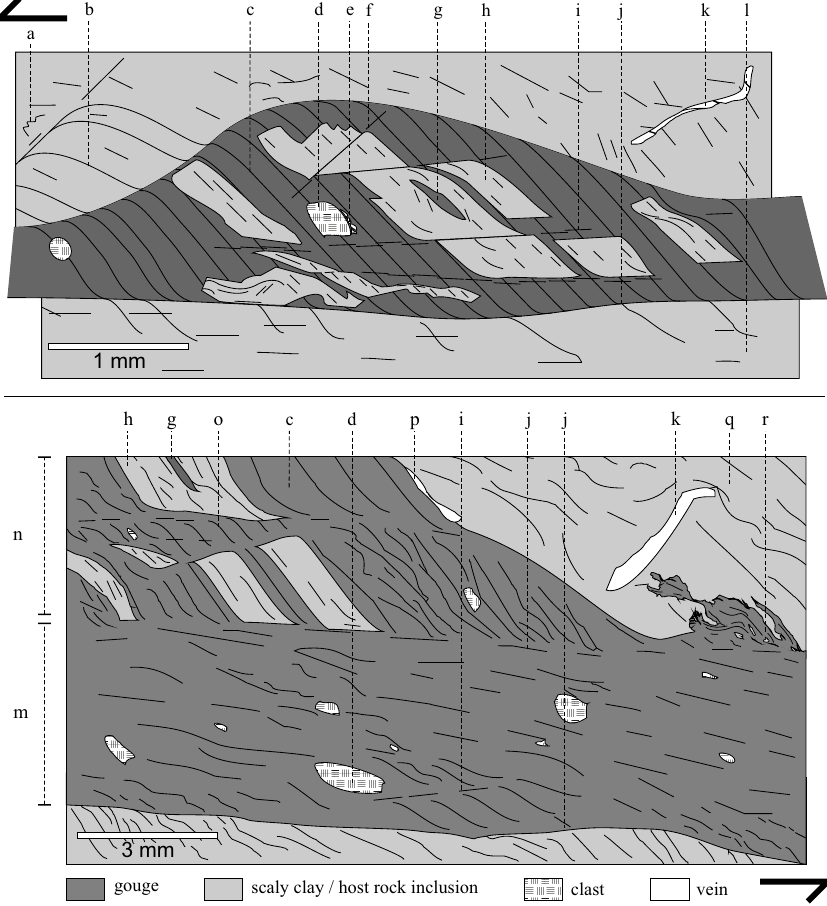
Figure 17. Generic sketches of gouge type 1 (top) and type 2 (bottom) summarizing all microstructural elements found (after Laurich, 2015). (a) Transpressional folding of foliations (occasional). (b) Sigmoidal foliation (resembling S-C fabric), fabric intensity higher than in other areas of scaly clay. (c) Intense uniform P foliation inside gouge domains (always). (d) Clast (pyrite, quartz, feldspar, calcite) parallel to subparallel to P foliation. (e) Spalled fragments of clast (common in calcite clasts). (f, i, j) Localized shear bands, always synthetic: (f) in R orientation, rare in gouge with low-angle P foliation, (j) in Y orientation, (i) foliation parallel to gouge domain boundary (always if boundary is parallel to shear sense). (g) Gouge lens inside host rock inclusion (occasional). (h) Strained host rock inclusion (often). (k) Strained and fragmented vein in R orientation (occasional). (l) Scaly clay fabric with anastomosing foliation (no S-C foliation). (m) Type 2 gouge domain with P foliation subparallel to shear sense, no host rock inclusions and more clasts than in (n) . (n) Type 1 gouge domain with P foliation oblique to shear sense does contain host rock inclusions. (o) S-C fabric (common in type 1 gouge, rare in type 2). (p) Vein parallel to gouge boundary (occasional). (q) Scaly clay with foliation in P orientation. (r) Gouge “intrusion” pattern in wall